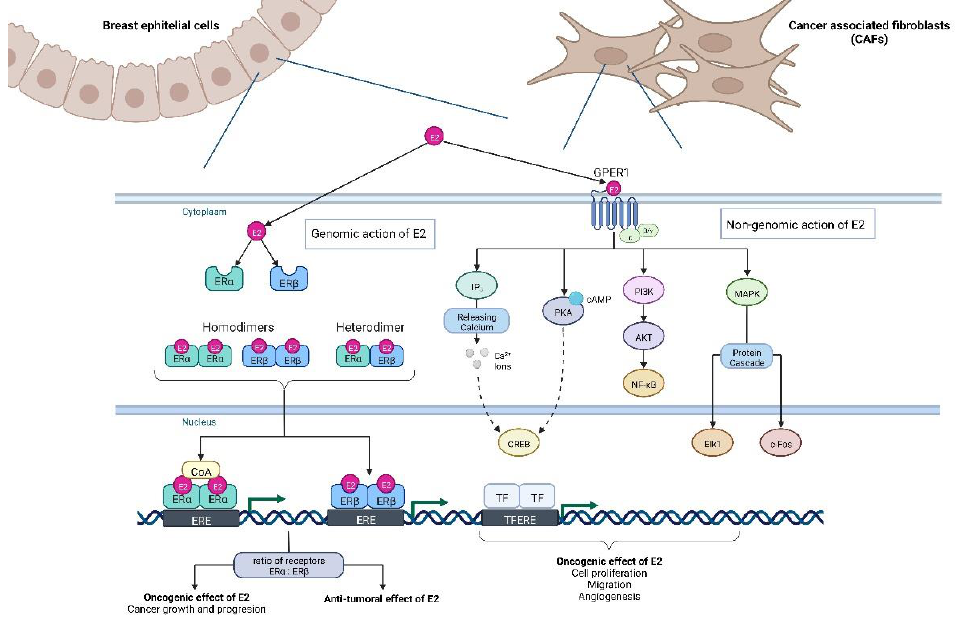
Figure 2. Estrogen Receptor signaling in breast epithelium cells and CAFs. Mechanisms of E2 action in cells can be divided into genomic action through binding to nuclear estrogen receptors ER α or Er β , and non-genomic action by binding to GPER1 [131]. ER α and ER β are ligand-activated transcription factors that mediate the effect of estrogens by binding with specific estrogen response elements (EREs) in promotors of target genes, which regulate the transcription of these genes [132]. ER α and Er β , after activation by E2 binding, form homo- or heterodimers with each other. Activation of ER α promotes proliferation, tumor growth, and angiogenesis through the induction of expression of oncogenes like c-MYC, VEGF, or CCND1 [133–135]. The additional layer of the regulation of E2 genomic action is the interaction of ERs with various coactivators (CoA), such as transcription factor Sp1 (SP1), which modulate the binding of activated E2-ER complex with ERS [136]. Non-genomic action of E2 via binding to GPER1 leads to signal transduction through the G protein, which results in the synthesis of cAMP [137–139] and activation of downstream signaling pathways: phosphatidylinositol 3-kinase (PI3K), Akt kinase, Ca 2+ signaling, and MAP kinases [140]. In breast tumors, estrogenic activation of GPER1 leads to the induction of proliferation, migration, or angiogenesis [141,142]. GPER1 is expressed also in breast cancer CAFs [143–145]. Activation of GPER1 signaling may lead to an increase in CAFs proliferation rate or migration by induction oncogenes expressions like c-Fos or Cyclin D1 (CCND1) [146]. Additionally, Lappano et al. demonstrated that estrogenic activation of GPER1 in CAFs promotes breast cancer development by increasing angiogenesis via activation of HIF1- α and VEGF expression [147]. The next mechanism, which leads to the promotion of breast cancer progression by CAFs via GPER1, is the induction of the expression of pro-inflammatory cytokine IL1B and its receptor ILR1 in breast cancer cells and CAFs [148]. The above figure was created with BioRender.com. Agreement number: